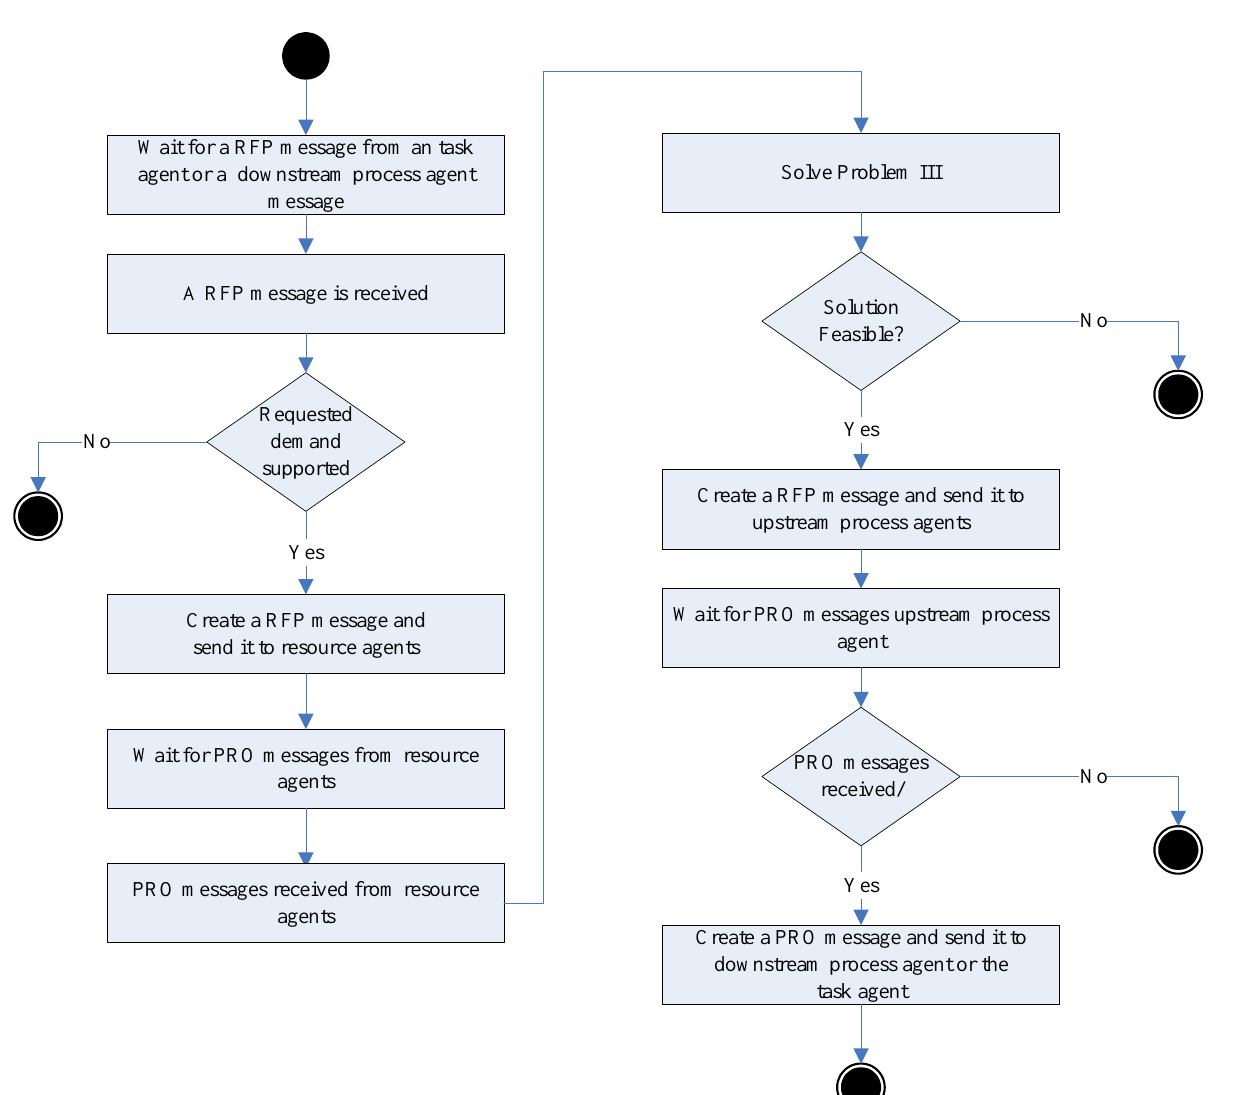
Figure 4. The flowchart to handle messages by a process agent.